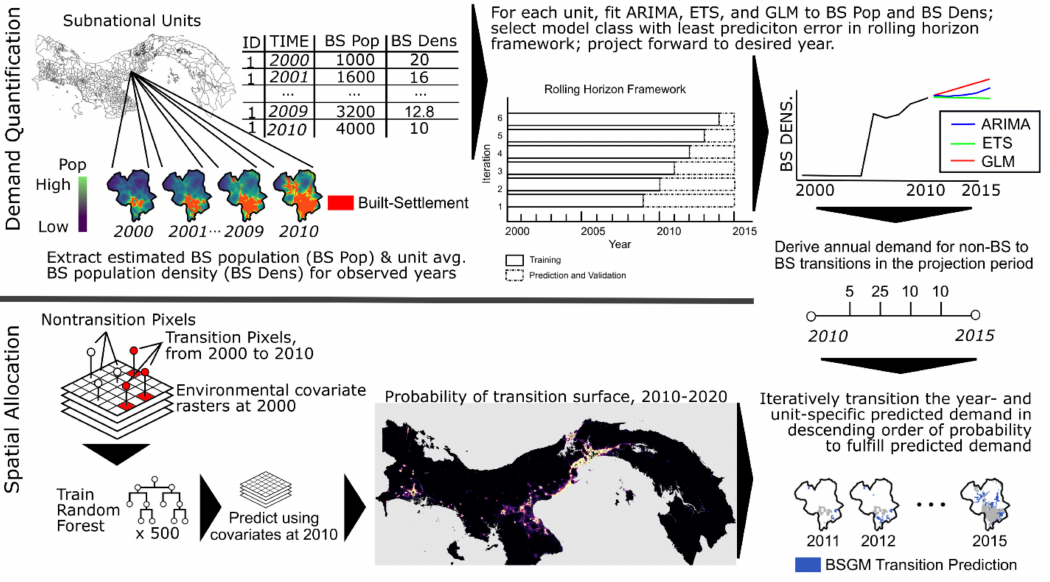
Figure 1. High-level generalization of the Built-Settlement Growth Model extrapolation (BSGMe) modelling framework when predicting for short-term Built-Settlement (BS) expansion. Note, example maps and numbers are not to scale. Figure modified from